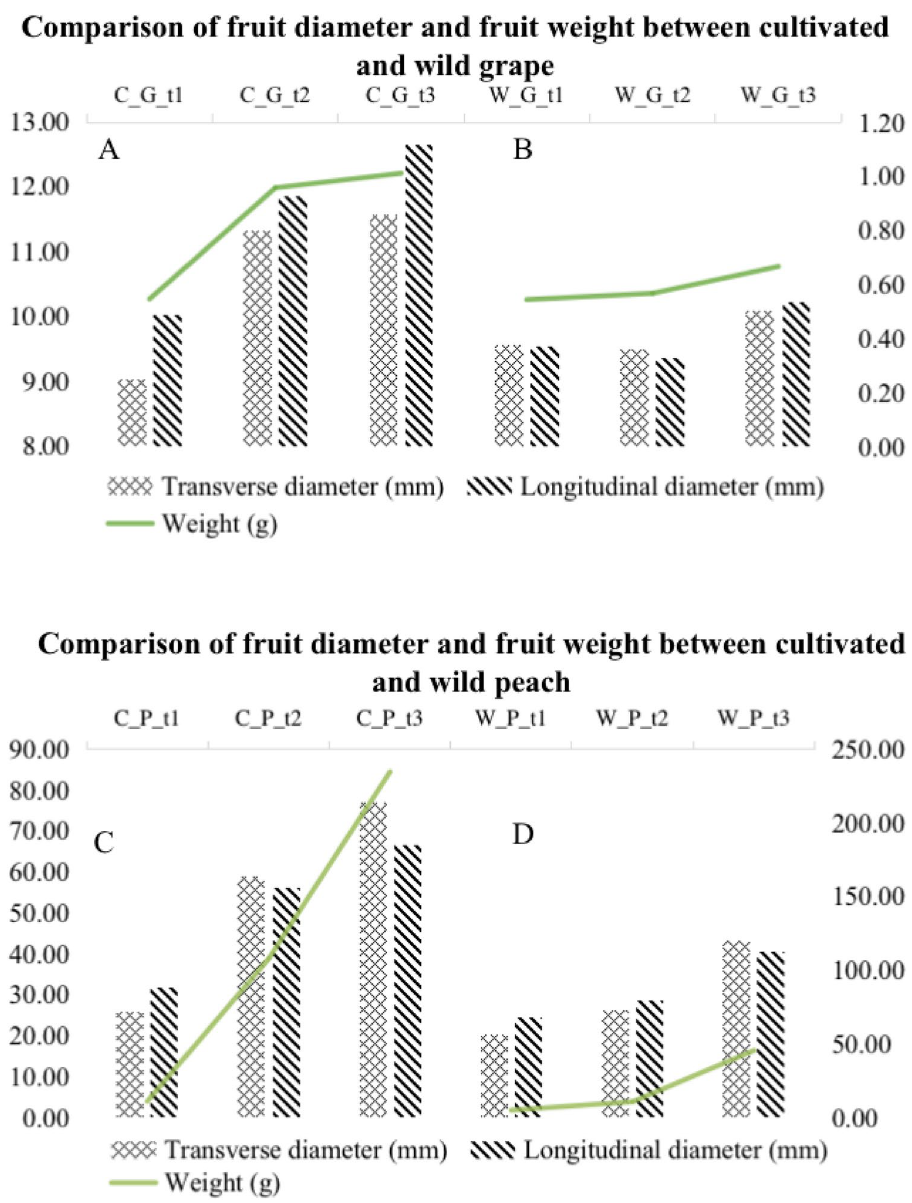
Figure 1. Comparison of fruit diameter and fruit weight between cultivated and wild grape and peach. Changes in the horizontal and vertical diameters and individual fruit weight of cultivated and wild grapes and peaches in the three periods. The top abscissa represents cultivated and wild samples in three periods. The left axis is the horizontal and vertical diameter (mm), and the right axis is the weight of a single fruit (g). The grid column represents the changing trend of the fruit’s horizontal diameter, and the diagonal column represents the fruit’s vertical diameter. The broken line represents the change trend of fruit weight. ( A ) refers to cultivated grape ‘Pinot Noir’, ( B ) refers to wild grape ‘Changbai No. 9’, ( C ) refers to cultivated peach ‘Okubo’, D refers to wild peach ‘Lianyungang